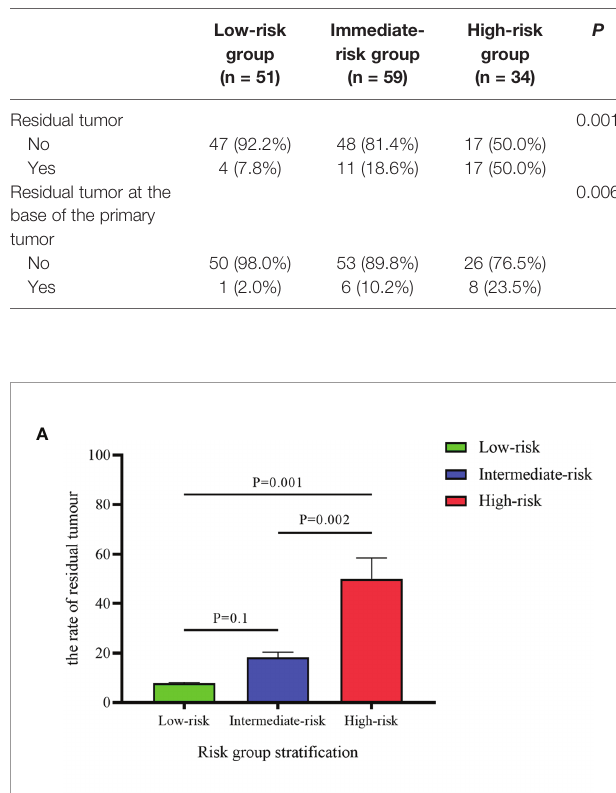
TABLE 4 | Rate of residual tumor at any location or base of the primary tumor in different risk